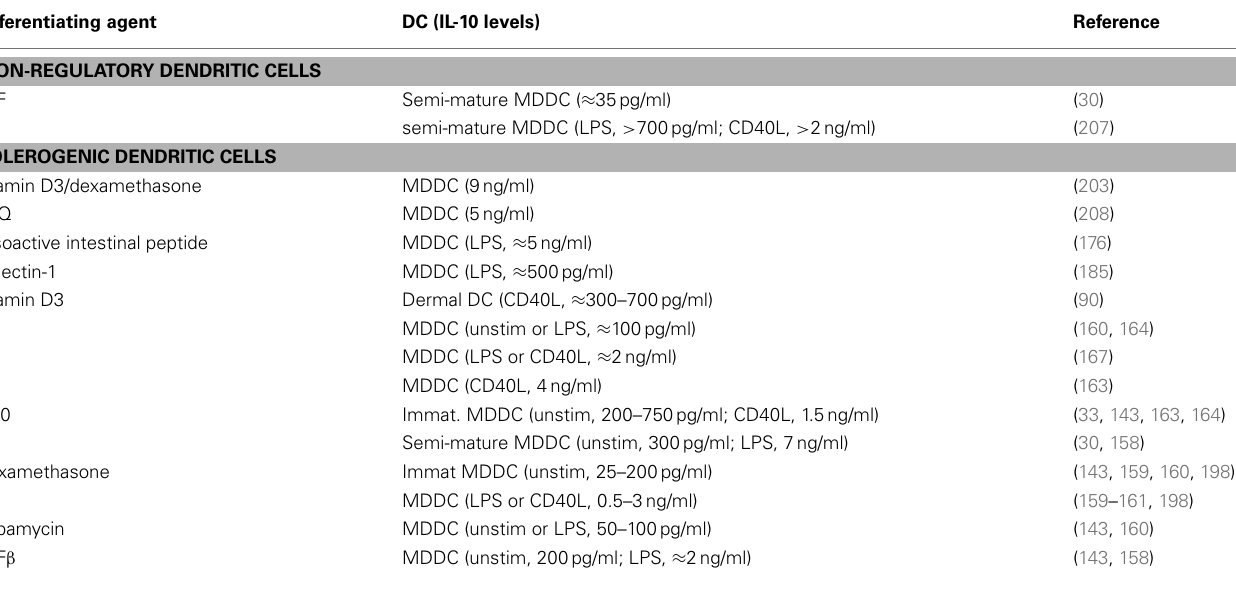
Table 2 | Impact of phenotype on the levels of IL-10 secretion by regulatory dendritic cells . Differentiating agent DC (IL-10 levels) NON-REGULATORY DENDRITIC